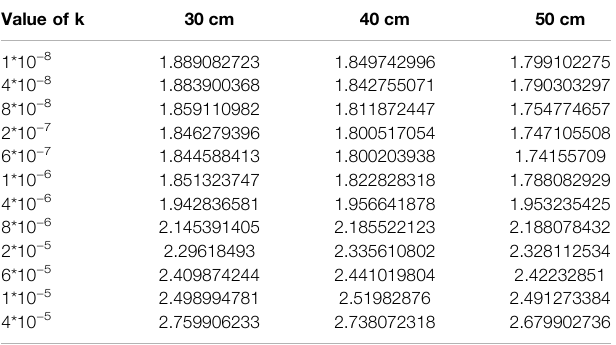
TABLE 1 | Heat diffusion coef fi cient corresponding to the solution variance. Value of k 30 cm